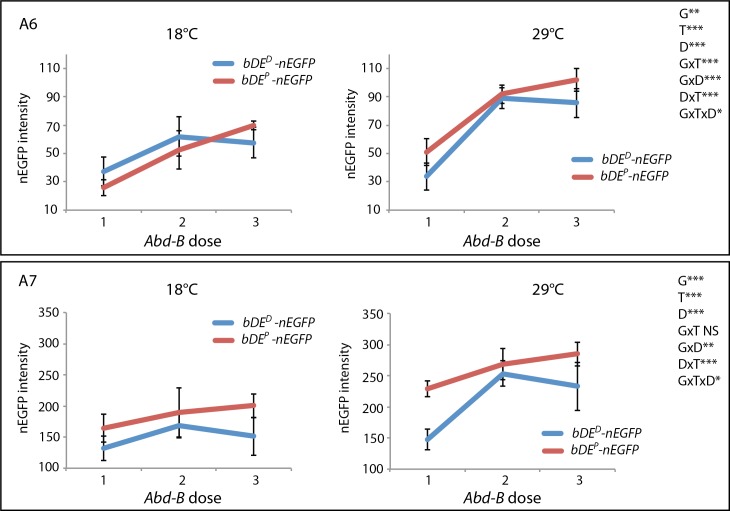
Abd-B dose, genotype and temperature modulate the activity of bDE.Quantification of nEGFP in A6 and A7 (n = 10 per condition) with variation of the temperature (T: 18°C or 29°C), Abd-B dose (D: 1, 2 or 3) and genotype (G: bDED or bDEP). Three-way ANOVA were performed for each segment on Box-Cox transformed measures of nEGFP intensity extracted from nEGFP positive nuclei. * p<0.05; **p<0.01; ***: p<0.001. NS: non significant.